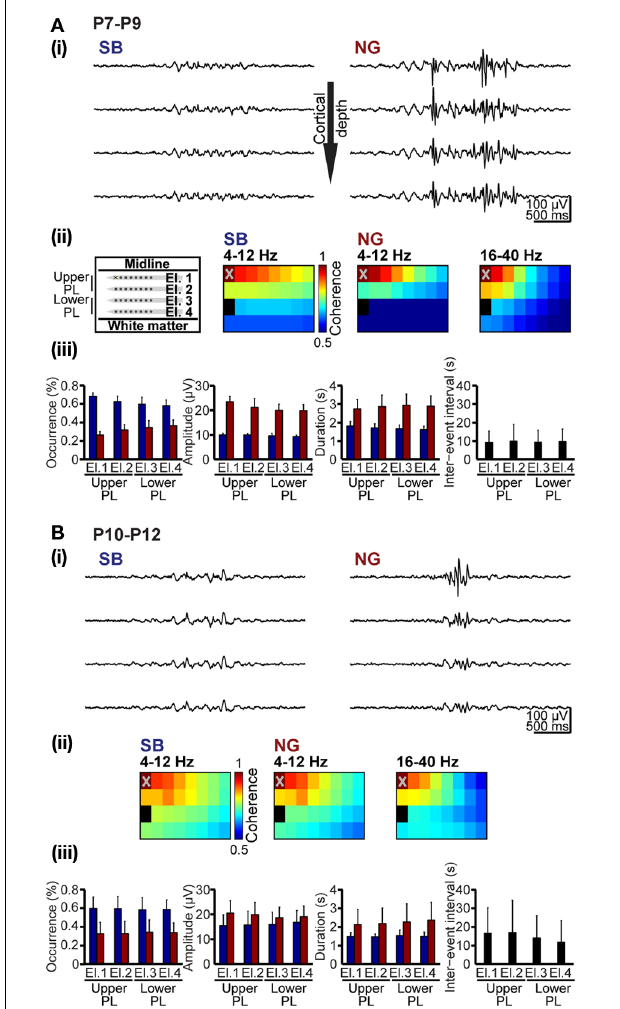
FIGURE 8 | Spatial and temporal organization of synchrony patterns over the developing PL. (A) Frequency-dependent synchrony over the upper and lowers layers of the PL in neonatal rats. (i) Characteristic SB (left) and NG (right) recorded at different cortical depth (corresponding to El.1–4) and displayed after band-pass filtering (4–100Hz). (ii) Color-coded mean coherence coefficients maps calculated for the frequency components 4–12Hz of SB and NG as well as for 16–40Hz of NG recorded from 6 P7-9 rats with 4 × 8 arrays (left panel). The deepest recording site on the electrode shank closest to the midline (marked by X on El.1) was chosen as reference channel. (iii) Properties of SB and NG detected and classified using the unsupervised method. Bar diagrams display the occurrence, amplitude and duration of neonatal SB (blue bars) and NG (red bars) as well as duration of inter-event intervals on El.1–4. (B) Frequency-dependent synchrony over prelimbic layers of pre-juvenile rats. (i) Characteristic SB (left) and NG (right) recorded at different cortical depth (corresponding to El.1–4) and displayed after band-pass filtering (4–100Hz). (ii) Color-coded mean coherence coefficients maps calculated for the frequency components 4–12Hz of SB and NG as well as for 16–40Hz of NG recorded from 6 P10-12 rats with 4 × 8 arrays (left panel). The deepest recording site on the electrode shank closest to the midline (marked by X on El.1) was chosen as reference channel. (iii) Properties of SB and NG detected and classified using the unsupervised method. Bar diagrams display the occurrence, amplitude and duration of pre-juvenile SB (blue bars) and NG (red bars) as well as duration of inter-event intervals on